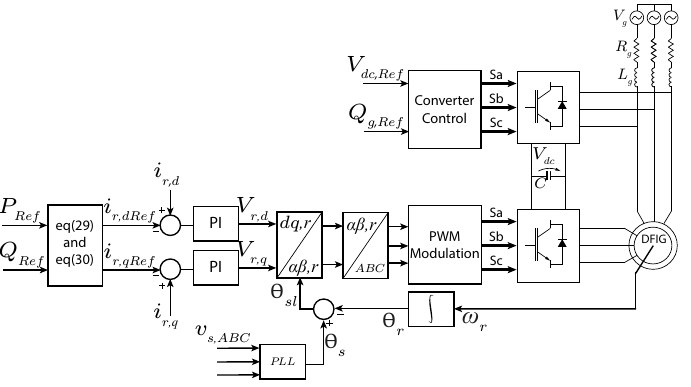
Figure 11. Block diagram of the current control based on power references for